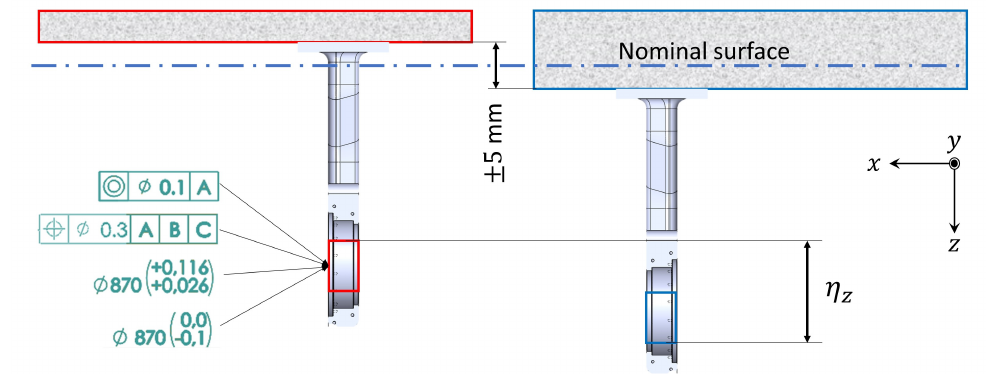
Figure 8. Horizontal deviations: scheme of the effect of tolerances on the position of the centers of the bearings. The blue and red rectangles in the bearings represent a qualitative illustration of the region where it is possible to have the center of each